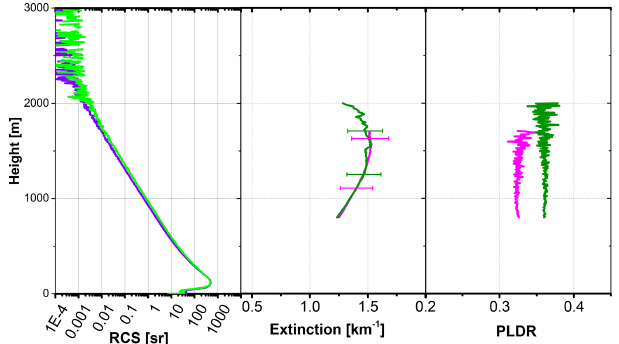
Figure 8. Case 2: lidar-derived parameters at 15:00–24:00UTC, 24 April 2019. (a) The Raman lidar signals at 530 and 387nm, (b) the extinction coefficients at 355 and 532nm, and (c) the PL- DRs at 355 and